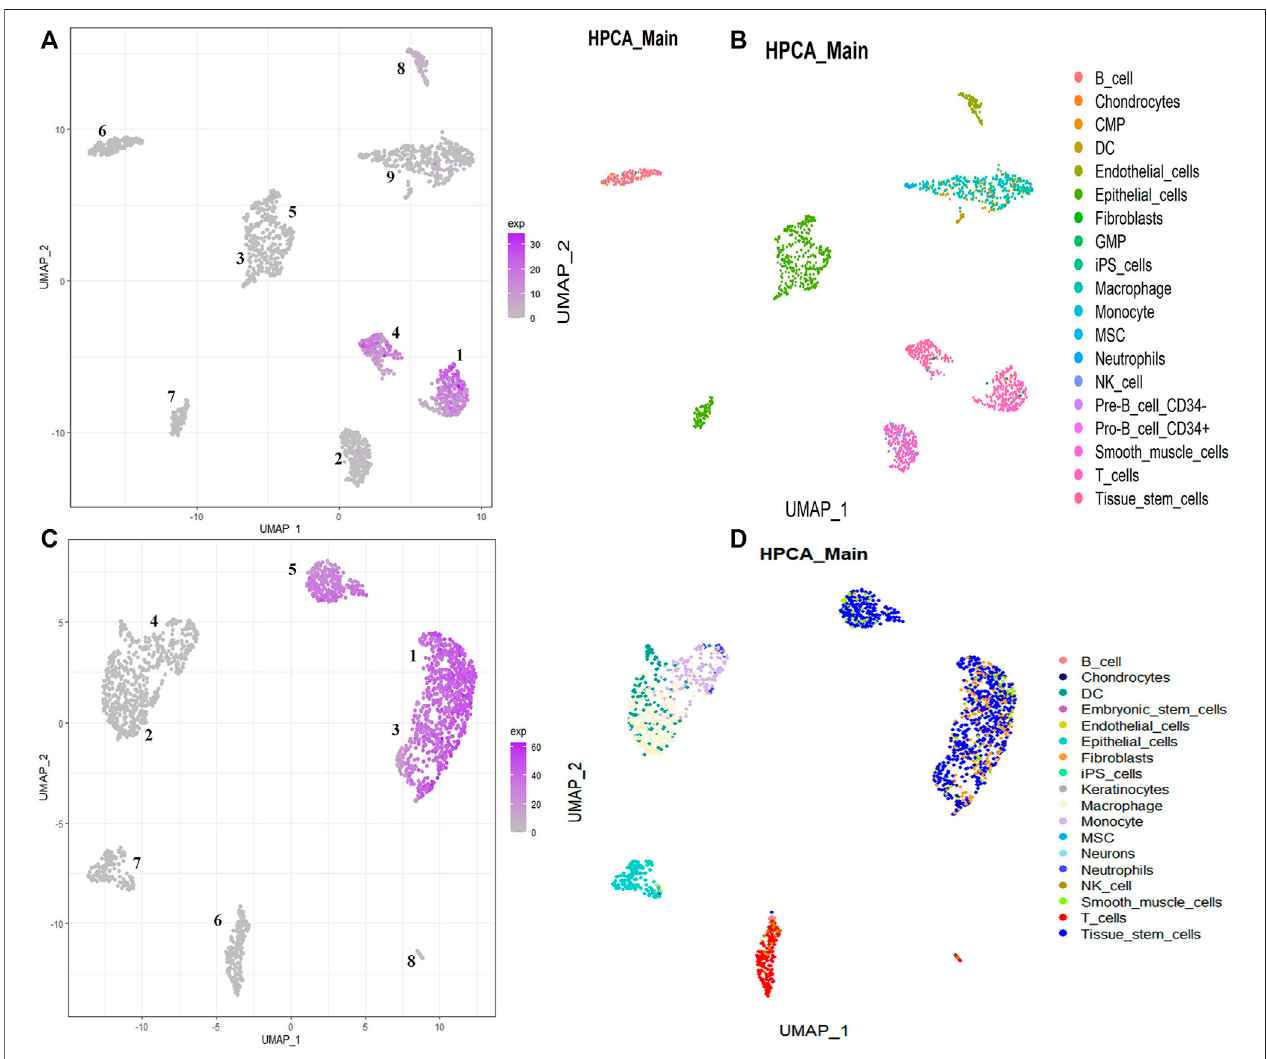
FIGURE 6 | Visualizing each cell population using UMAP. The distribution of individual cell populations in single-cell data. (A,C) The main distribution of stemness- related key genes in all cell populations. (B,D) The proportion of each cell type in each cell population.